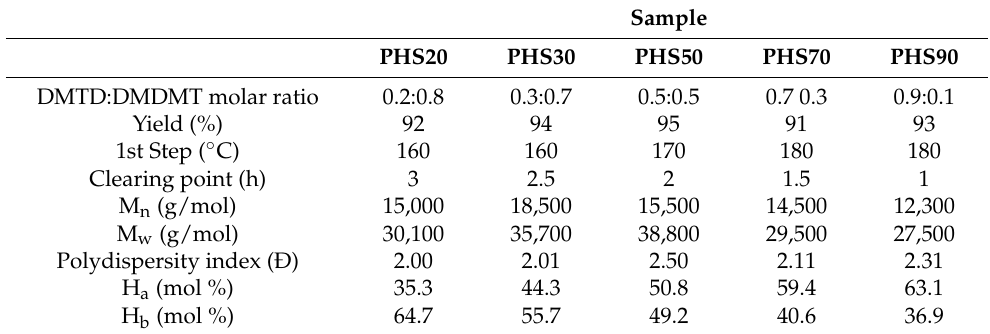
Table 1. Synthesis conditions for copolyesters PHS(20–90).